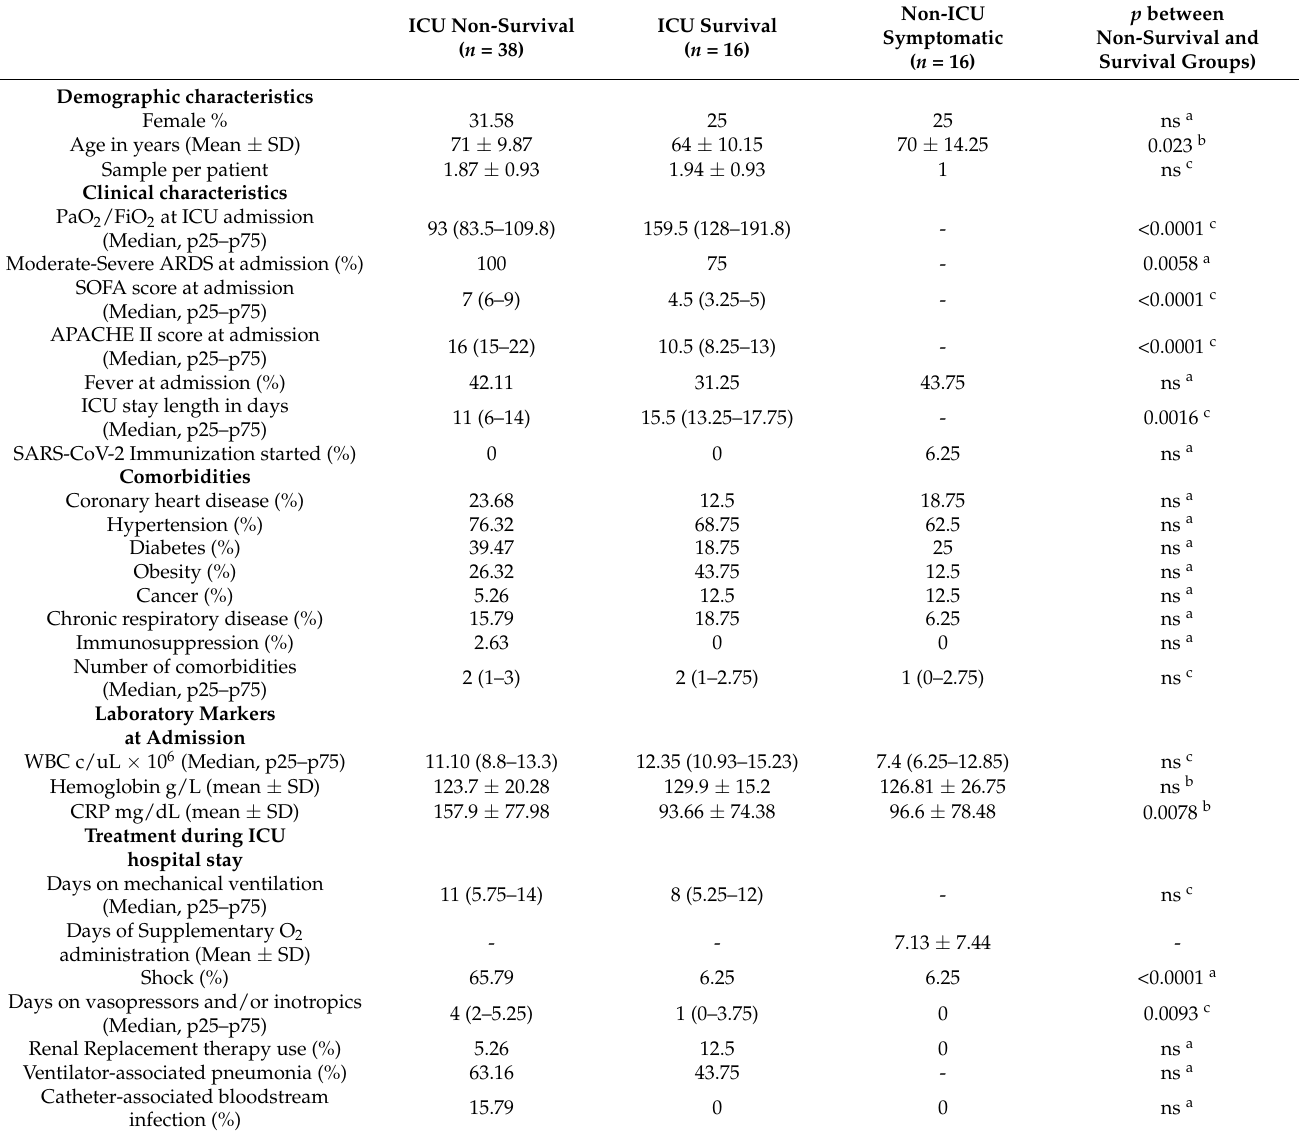
Table 1. Demographic and clinical characteristics of the patients included in this study, classified by their ICU stay and outcome. Non-ICU ICU Non-Survival ICU Survival Symptomatic ( n = 38) ( n = 16) ( n =